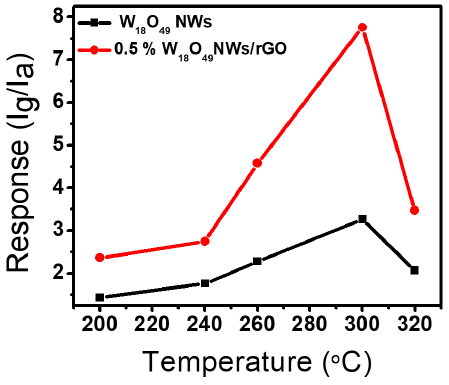
Figure 4. Gas sensing response of pure W 18 O 49 NWs and 0.5 wt. % W 18 O 49 NWs/rGO composite towards 100 ppm toluene vapors at different temperature.